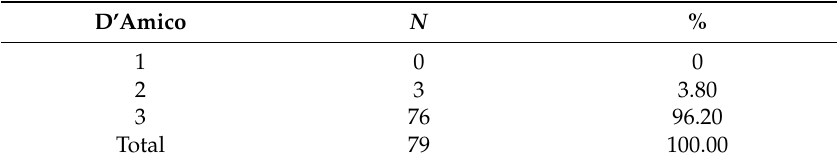
Table 5. Frequency of important clinical parameters for the study cohort. D’Amico risk classification for